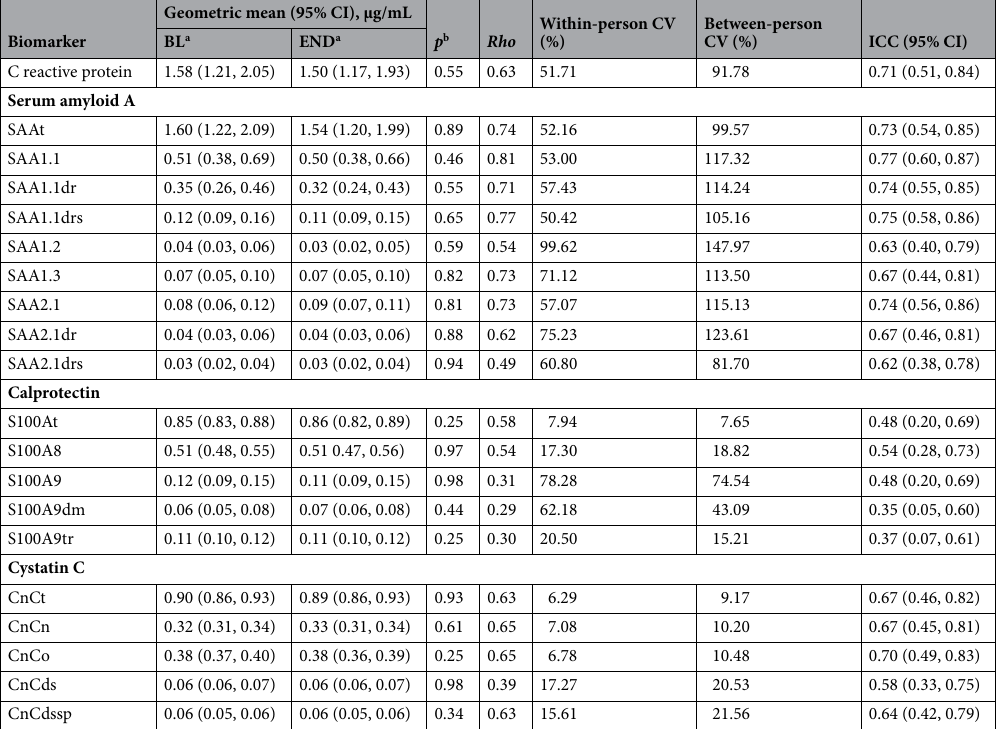
Table 3. Concentrations and within-person reproducibility of biomarkers in EDTA plasma samples from OMEGA. Samples collected at 2 time points over 16 weeks apart from 38 subjects in the OMEGA Trial. Within- and between-person CVs were determined by taking the square root of the within- and between- person variance components from random-effects mixed model on the ln-transformed scale. a BL Baseline, END End of follow-up. b Significant differences in biomarker geometric mean were evaluated by